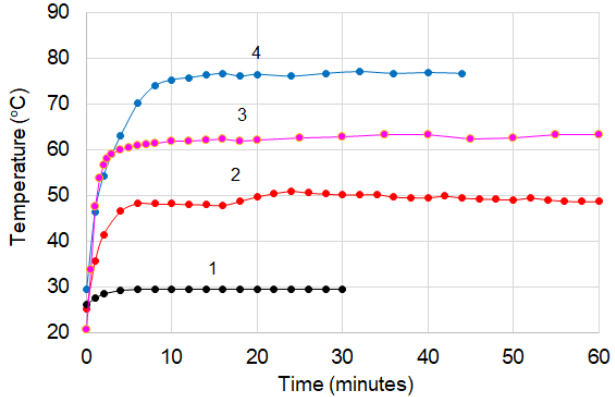
Figure 5. The surface temperature (T s ) vs. time for (CB + Gr)/HD composite with different histo-